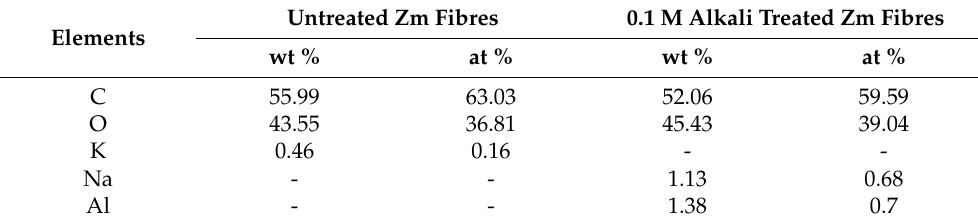
Table 5. Weight % and Atomic % of various elements present in untreated and alkali treated Zm fibres. Elements